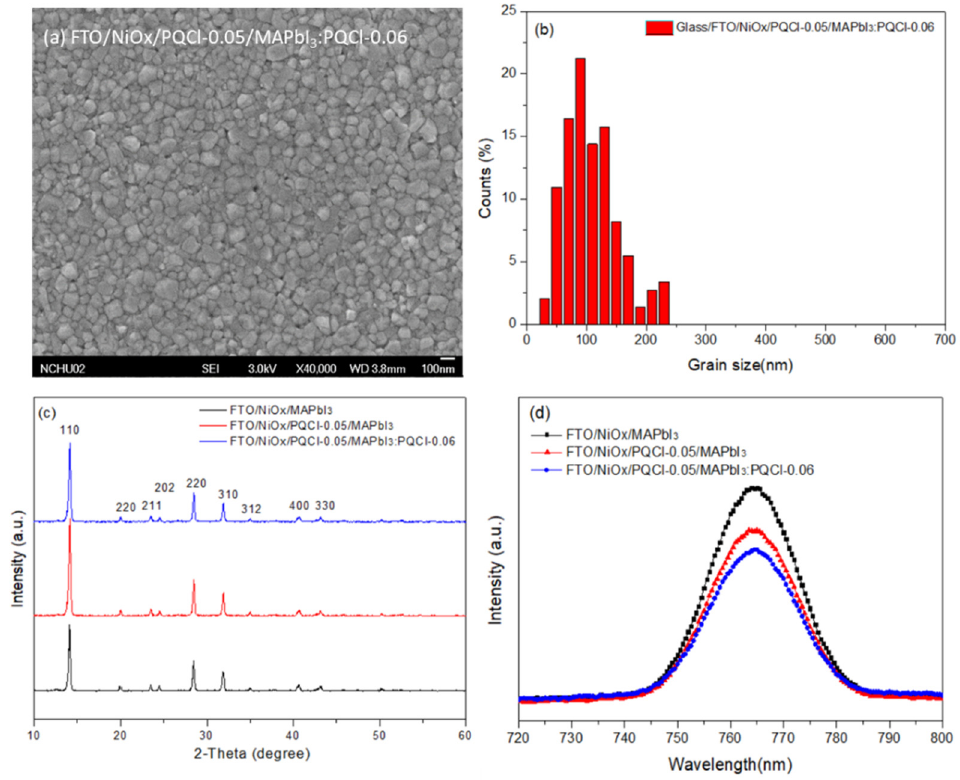
Figure 15. ( a ) SEM image, ( b ) MAPbI 3 grain size distribution, ( c ) XRD pattern, and ( d ) PL spectrum of the PQCl-incorporated MAPbI 3 film coated on the NiO x layer.